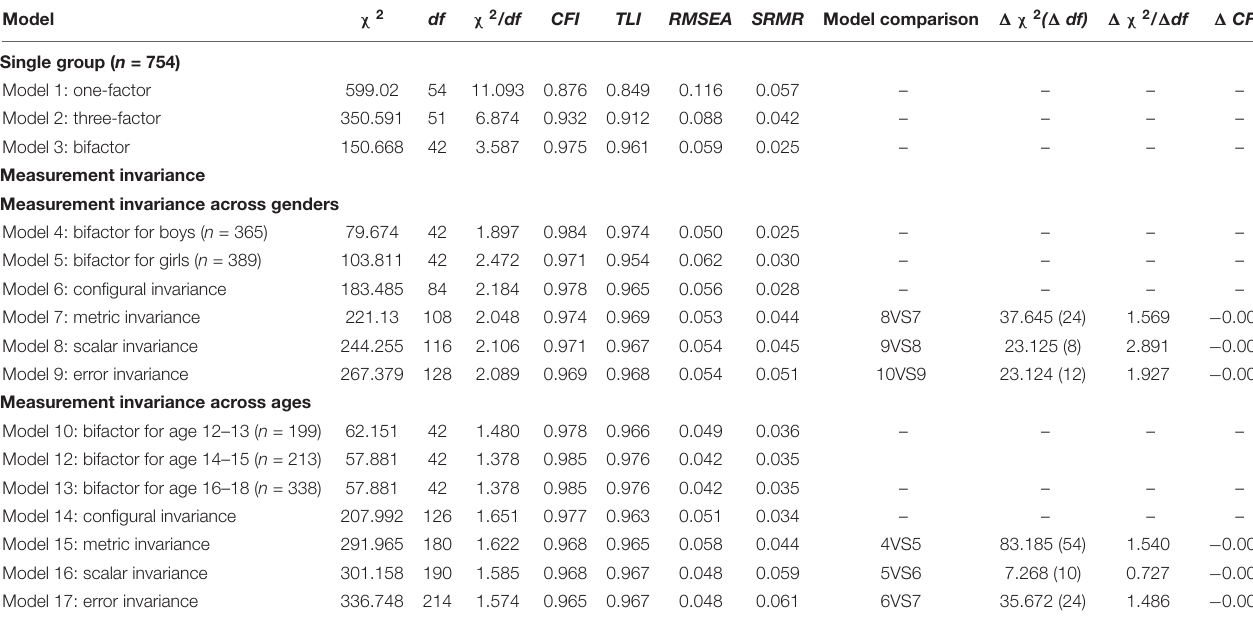
TABLE 2 | Goodness-of-fit statistics for tested